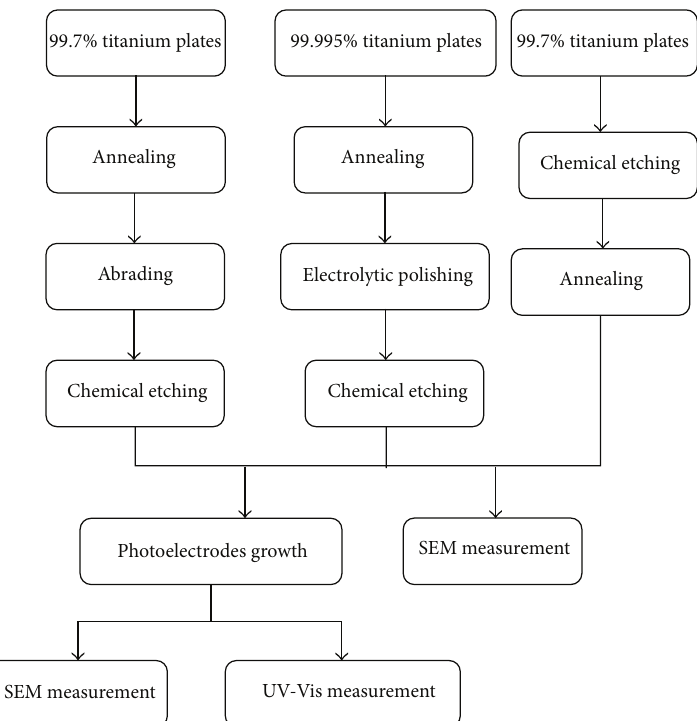
Figure 1: Experimental flow chart.